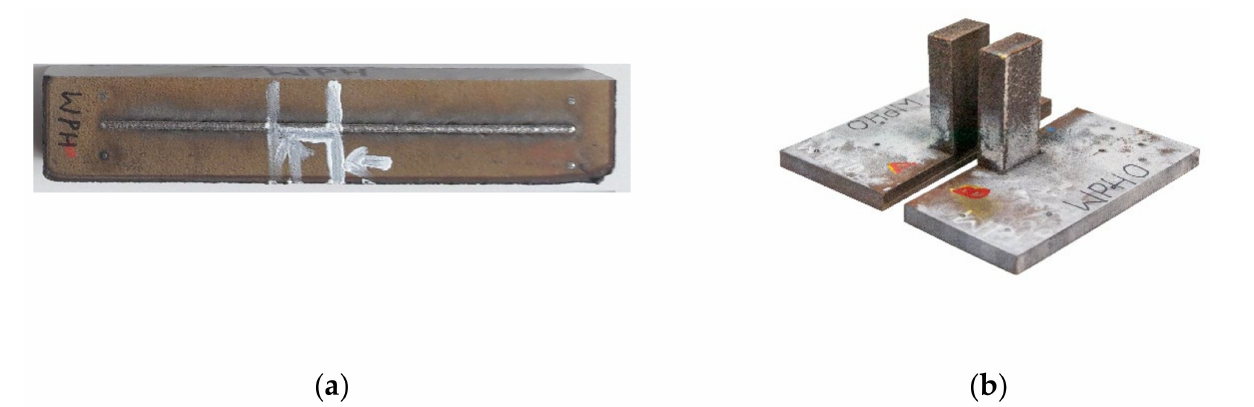
Figure 3. ( a ) Single-track deposition ( b ) Multi-track cuboid structure.